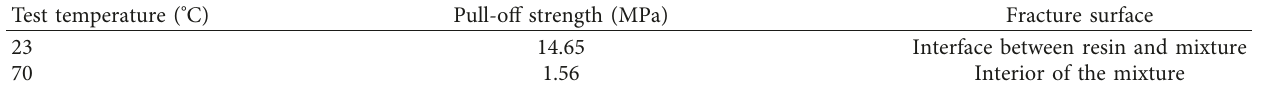
Table 2: Bond strength of high-toughness resin with epoxy asphalt concrete.